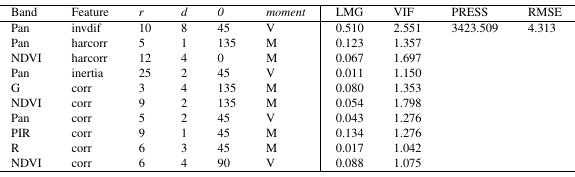
Table 8: Optimal image feature subset for age retrieval